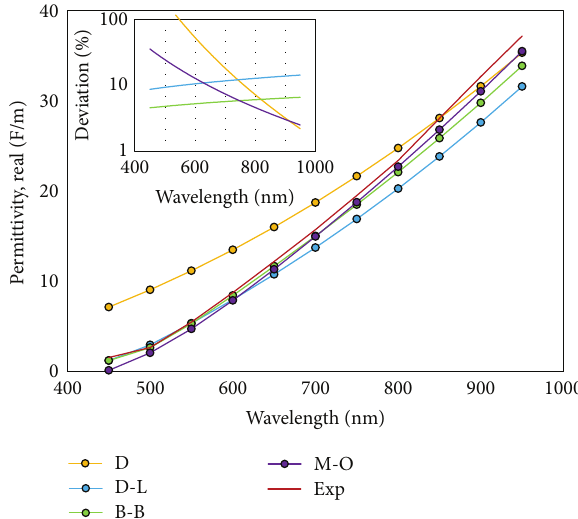
Figure 1: Real part of permittivity (F/m) against wavelength (nm) for all four models compared to experimental data. Inset: error value of the permittivity against wavelength indicating the accuracy of the B-B model with less than 10% deviation.